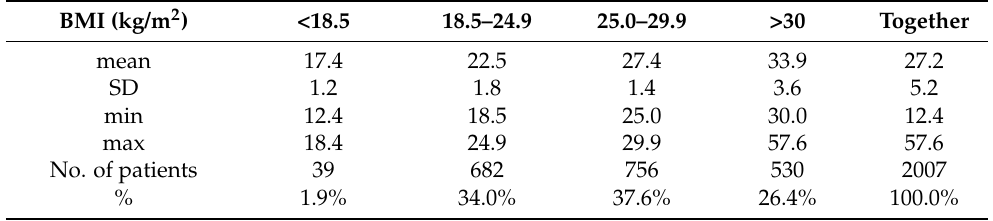
Table 2. Height, body mass, age, and BMI of patients operated on in the Department of Orthopedic Surgery and Traumatology in a consecutive 12 months (January–December 2017).